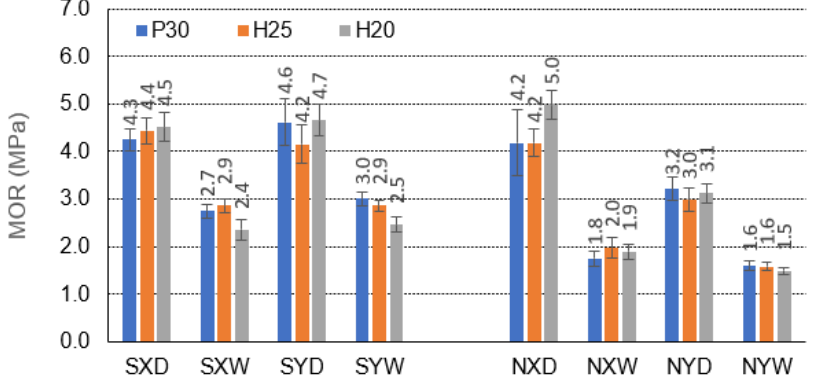
Figure 6. Illustration of the MOR relationship of honeycomb panels with a core of C-cells. Whiskers represent standard deviations.